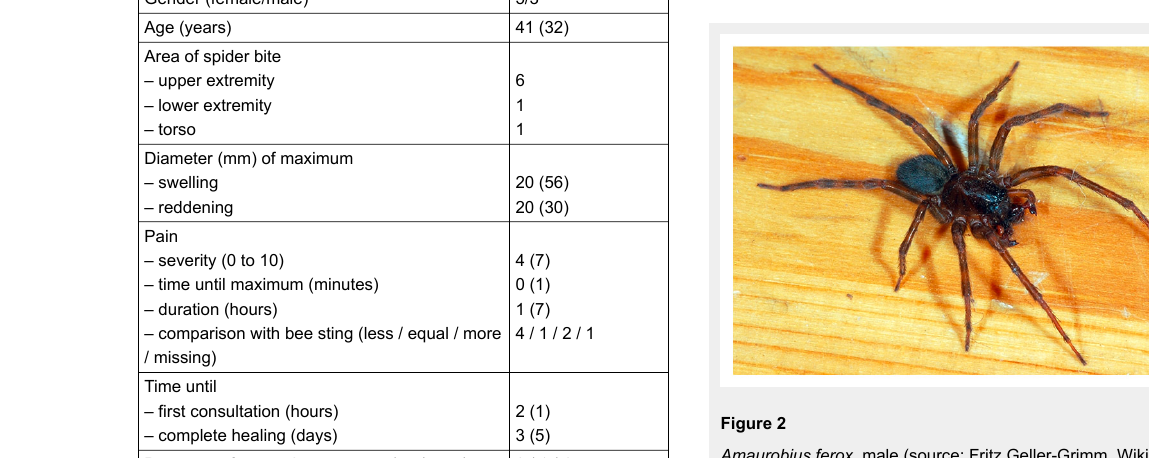
Table 1: Characteristics of patients and their clinical presentation. Numbers denote median value (interquartile range) or frequencies. Gender